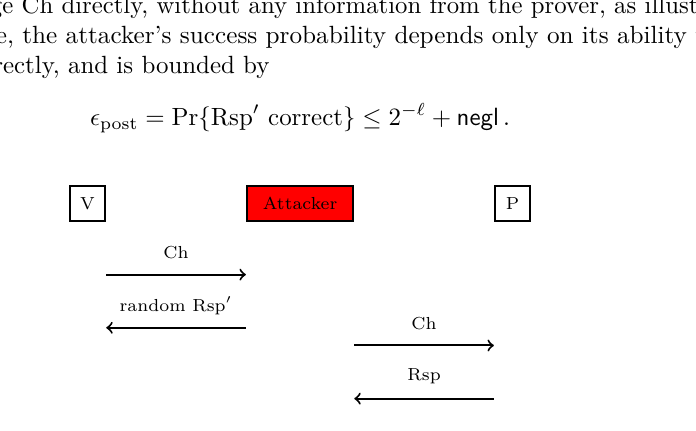
Figure 9: Post-ask strategy in a relay